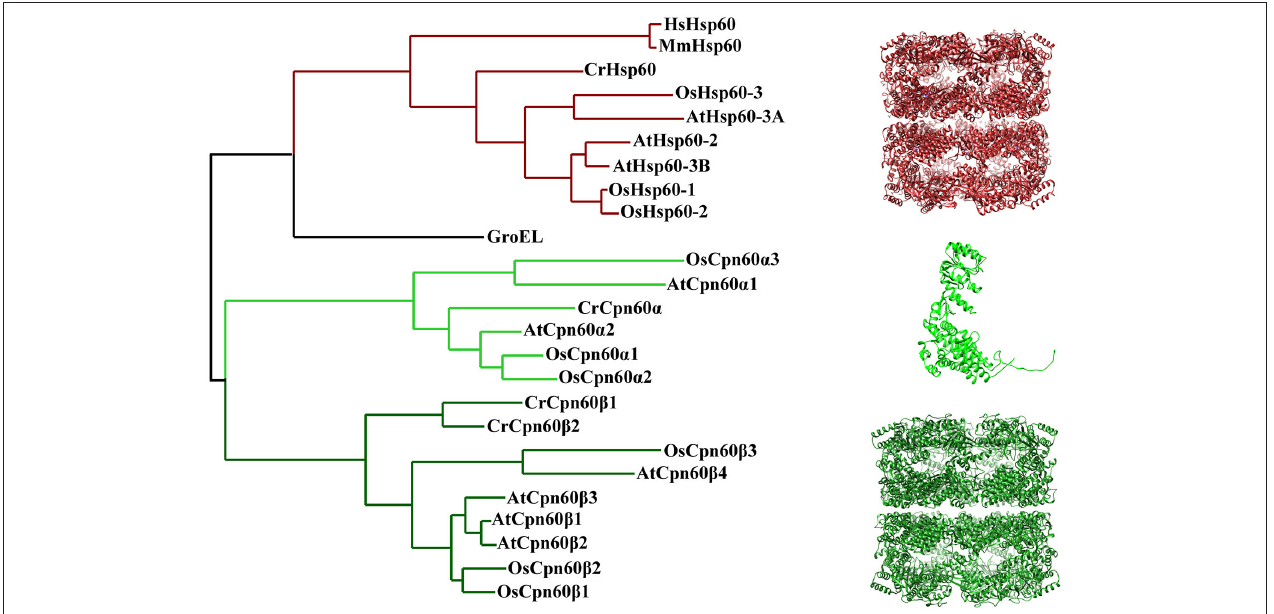
FIGURE 2 | Phylogenetic relationships of chaperonin proteins from bacteria, chloroplasts, and mitochondria. The tree was generated using Phylogeny (http://www. phylogeny.fr/). Protein sequences of E. coli , H. sapiens , and M. musculus chaperonin are from UniProt database [GroEL (P0A6F5), HsHsp60 (P108090), MmHsp60 (P63038)]. Protein sequence of plant mitochondria and chloroplast chaperonins are from Phytozome, TAIR and RGAP [CrHsp60 (Cre06.g309100), AtHsp60-2 (AT2G33210), AtHsp60-3A (AT3G13860), AtHsp60-3B (AT3G23990), OsHsp60-1 (Os10g32550), OsHsp60-2 (Os03g04970), OsHsp60-3 (Os05g46290), CrCpn60 α (Cre04.g231222), CrCpn60 β 1(Cre17.g741450), CrCpn60 β 2 (Cre07.g339150), AtCpn60 α 1 (At5g18820), AtCpn60 α 2 (At2g28000), AtCpn60 β 1 (At5g56500), AtCpn60 β 2 (At3g13470), AtCpn60 β 3 (At1g55490), AtCpn60 β 4 (At1g26230), OsCpn60 α 1 (Os12g17910), OsCpn60 α 2 (Os03g64210), OsCpn60 α 3 (Os09g38980), OsCpn60 β 1 (Os06g02380), OsCpn60 β 2 (Os02g01280), OsCpn60 β 3 (ChrSy.fgenesh.gene.28)]. The molecular structure was generated by UCSF Chimera (Pettersen et al., 2004) using CrCpn60 β 1coodinates 5CDI from Protein Data